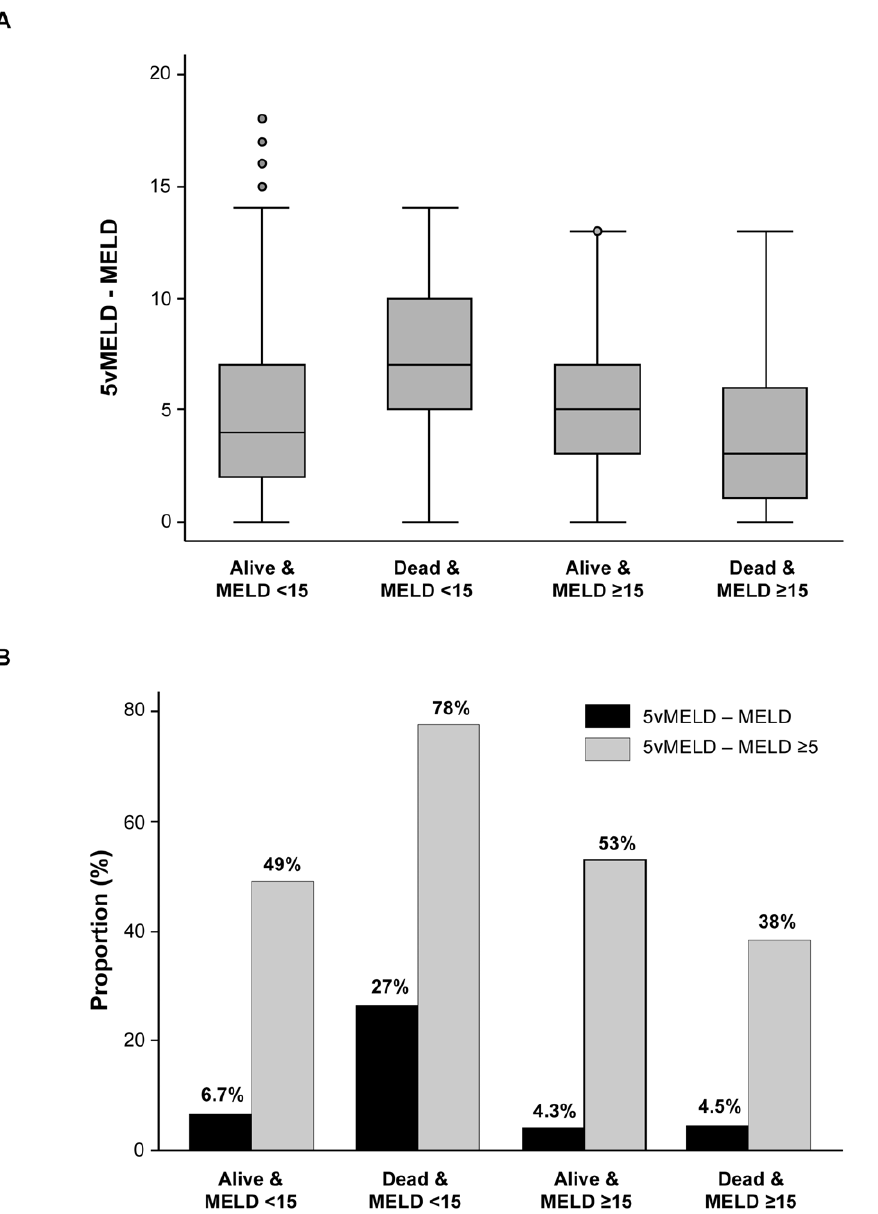
Figure 3. Difference between 5vMELD and MELD according to MELD score ( , vs. $ 15) at waiting list registration and 3-month mortality. (A) Patients who died despite low MELD scores would have had the largest increase in points had a 5vMELD-based policy been in place ( P =0.0001). (B) The proportion of patients with a difference between 5vMELD and MELD of $ 10 and $ 5 points was highest among low MELD patients who died (both P ,